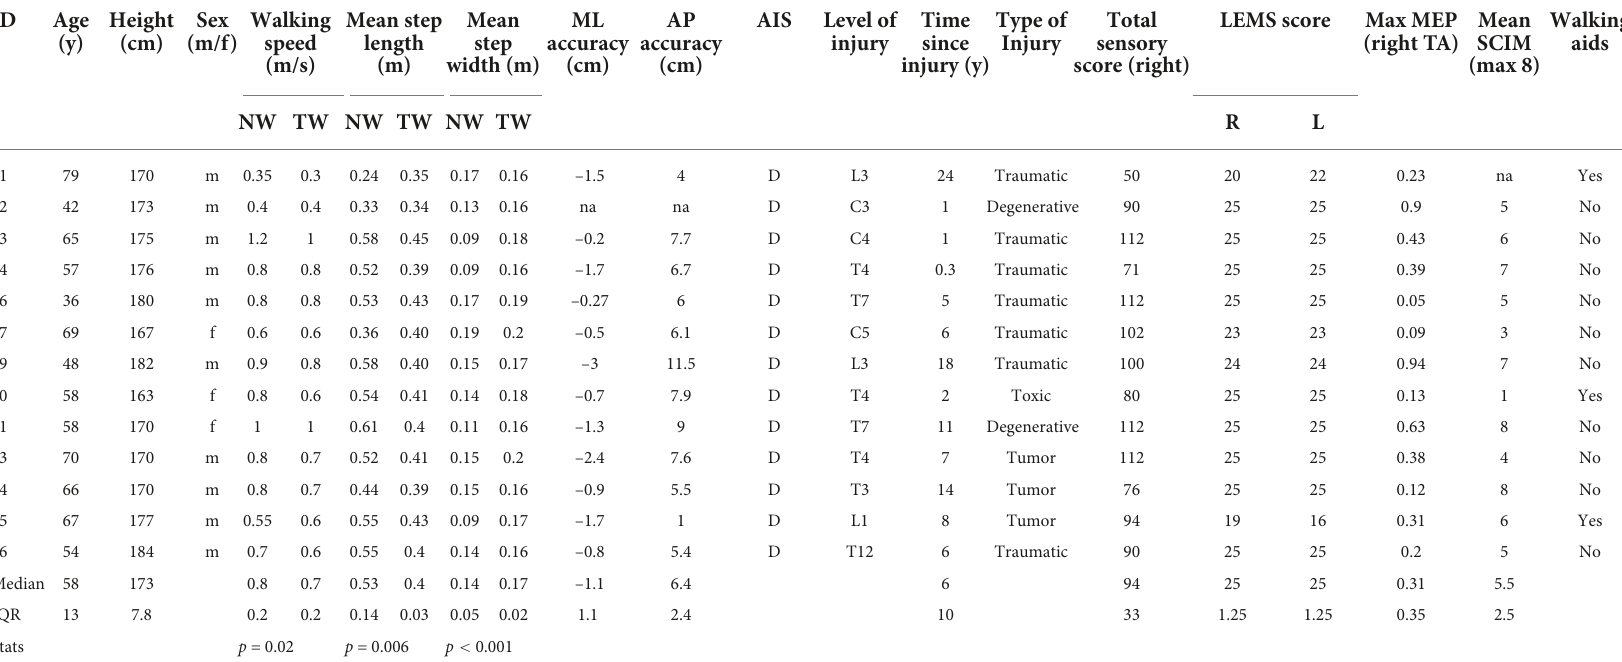
TABLE 1 Incomplete spinal cord injury